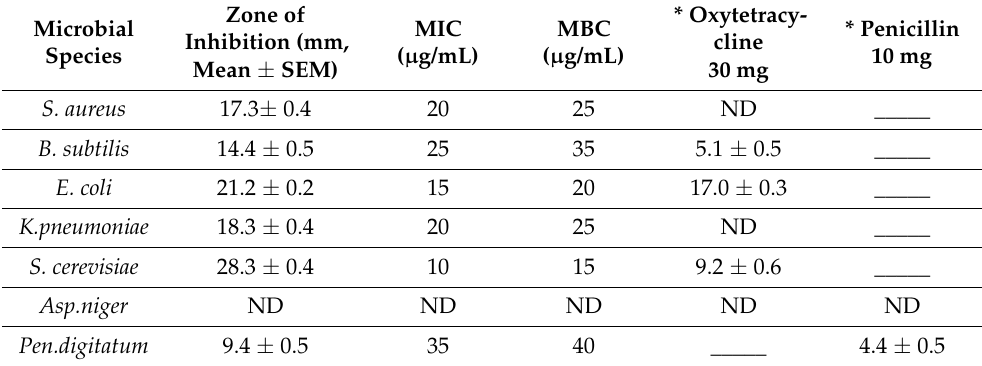
Table 4. Measurement of inhibition zone diameter, Minimum Inhibition Concentration MIC, and Minimum Bactericidal Concentration of Opuntia ficus-indica seed